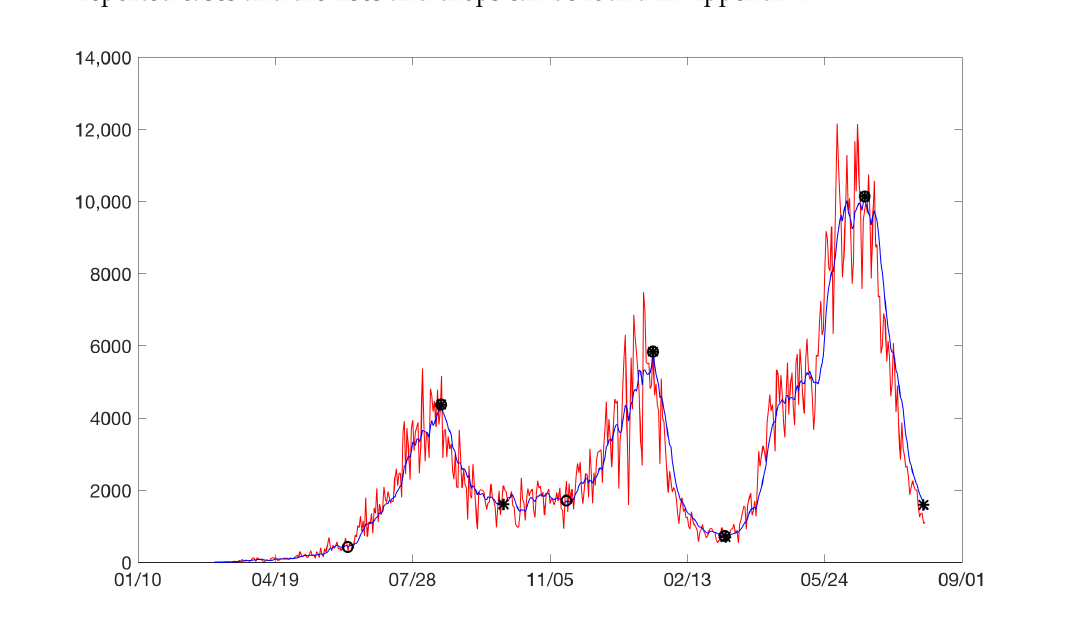
Figure 3. Bogota: on the horizontal axis is the date in days and on the vertical axis are the daily cases. Increases are identified with circles and drops with asterisks. Daily cases without moving average (red). Daily cases with 7 days moving average (blue).